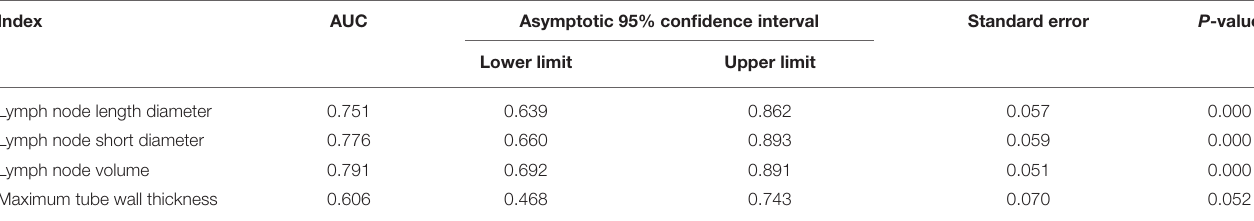
TABLE 2 | Value of imaging results in evaluating